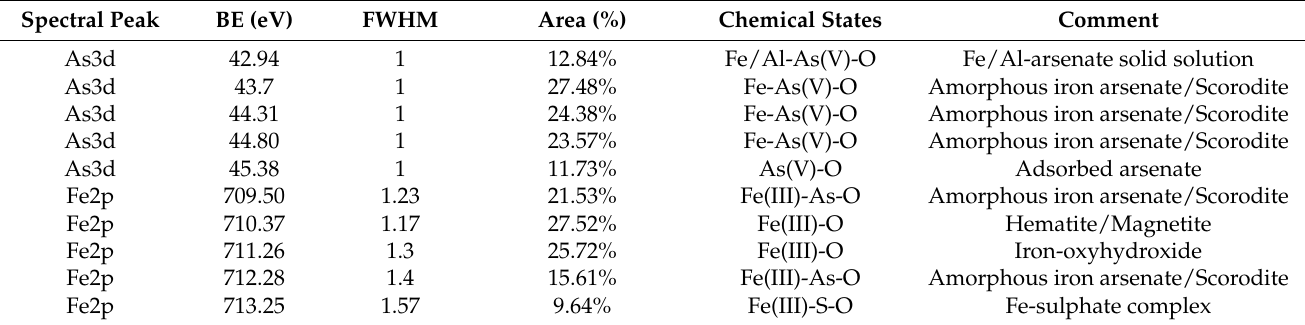
Table 5. XPS data and chemical states of the As-bearing precipitate obtained at 85 ◦